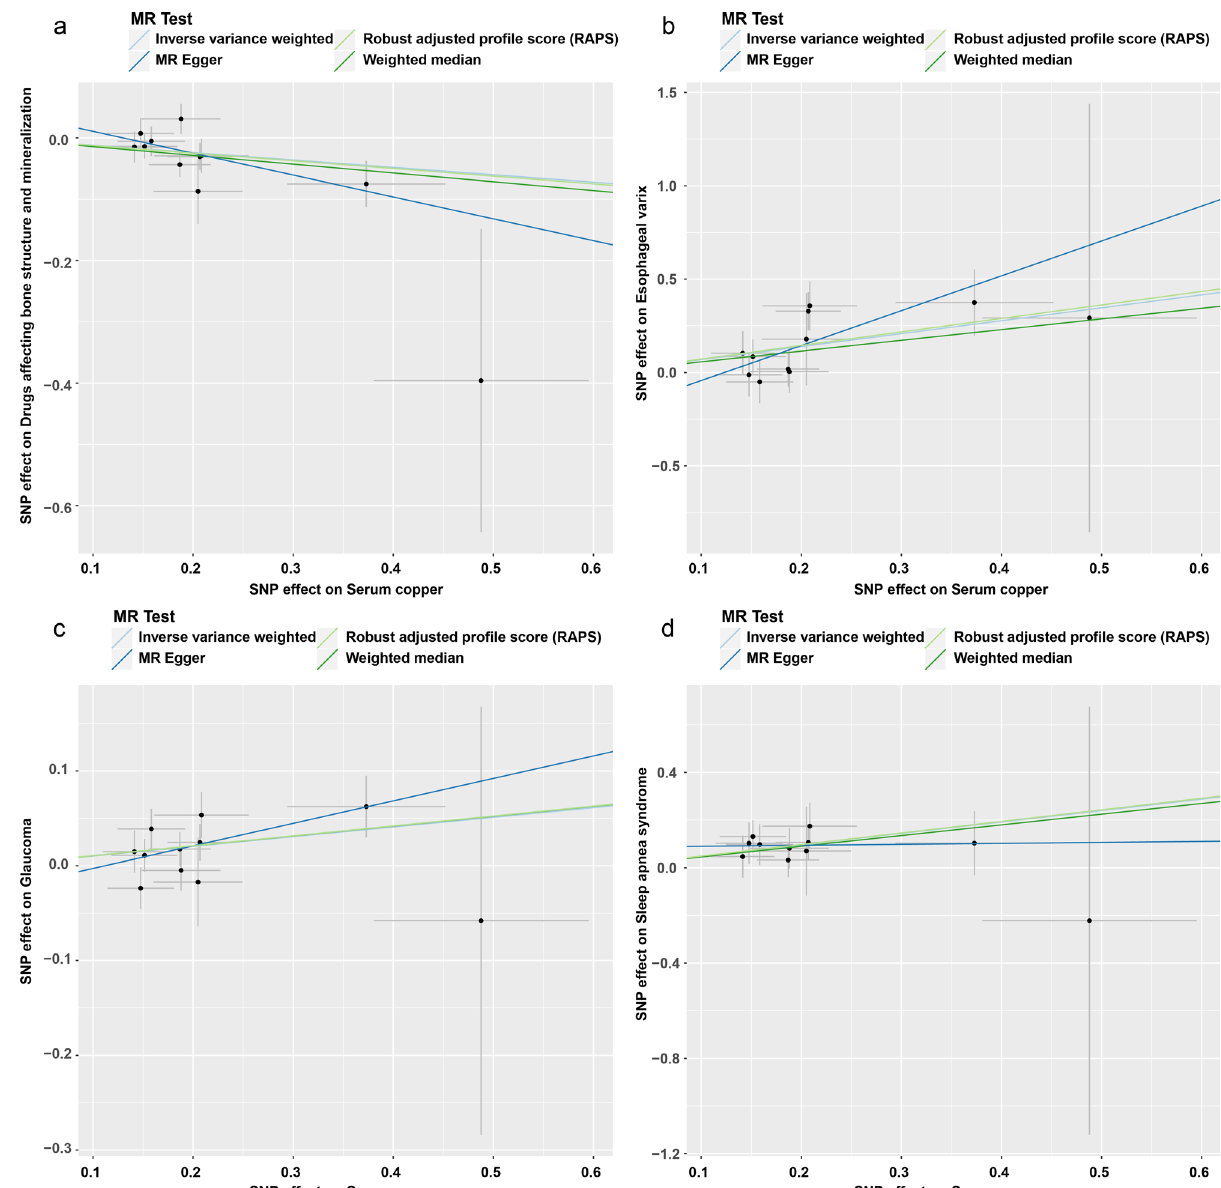
Fig. 2 Scatter plots for four robust results in the fi rst round two-sample Mendelian randomization analyses. The error bars indicate standard error. a Usage of drugs affecting bone structure and mineralization. b Esophageal varix. c Glaucoma. d Sleep apnea syndrome. MR Mendelian